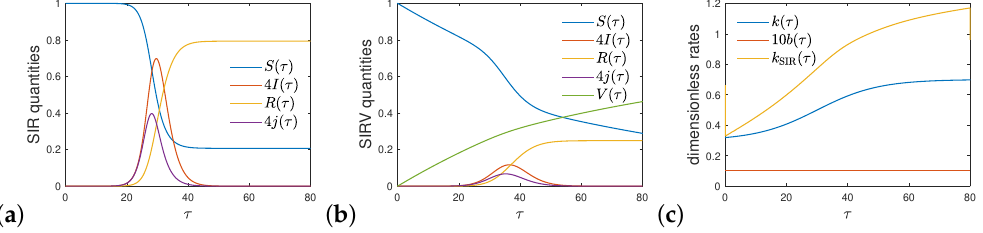
Figure 1. Solution to the ( a ) SIR and ( b ) SIRV models versus reduced time τ for k ( τ ) = 0.5 + 0.2tanh [ 0.05 ( τ − 30 )] , η = 10 − 8 and b ( τ ) = 0 and b ( τ ) = 0.01 in ( a ) and ( b ), re- spectively. Shown are S ( τ ) , I ( τ ) , R ( τ ) , V ( τ ) as well as j ( τ ) = S ( τ ) I ( τ ) . ( c ) Assuming that the data in ( b ) had been measured, k ( τ ) and b ( τ ) are correctly reconstructed from Equations (18) and (16). For comparison, we show k SIR ( τ ) obtained from Equation (19). The displayed values of I , j and b were multiplied by factors of 4, 4 and 10, respectively, in order to avoid overlarge